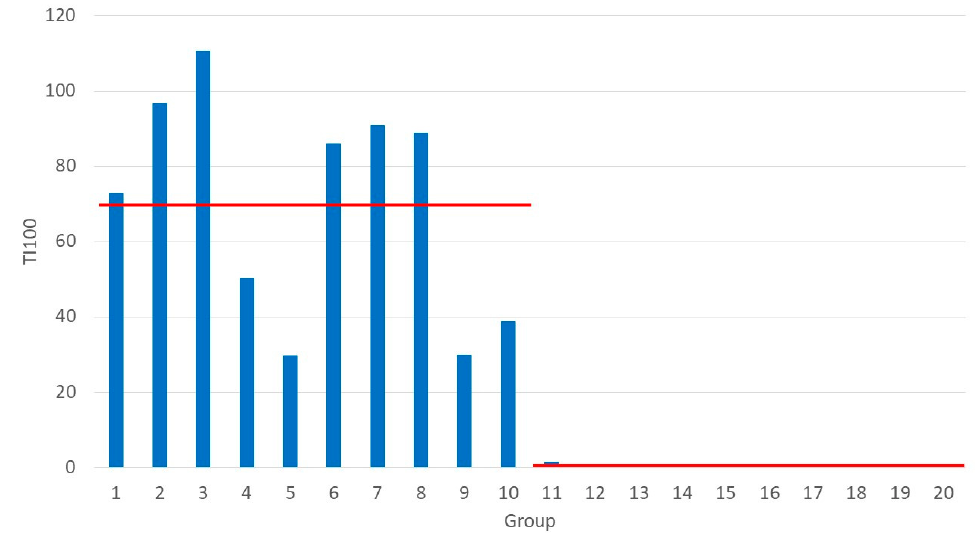
Figure 1. Treatment incidence 100 (TI 100 ) calculated as number of treatment days per 100 days in the nursery period. Group 1–10 are control piglets, and group 11–20 are vaccine-treated piglets. Red lines indicate the average TI 100 for both treatment groups: 69.43 ± 9.44 for the control group and 0.13 ± 0.13 for the vaccine-treated group. TI 100 is significantly ( p = 0.000022) different between both treatment groups.